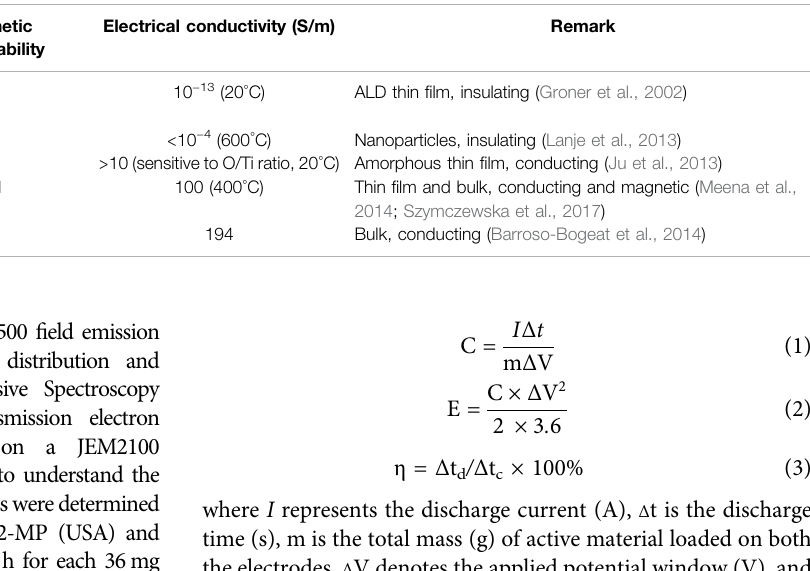
TABLE 2 | Electric and magnetic properties of materials of interest for